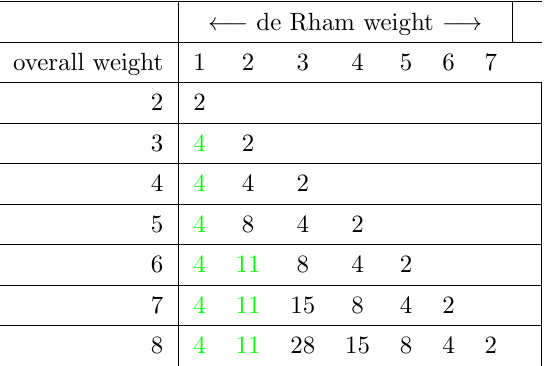
Table 17 . Dimensions of the space K (cid:25) of de Rham entries of the hexagon functions restricted to the line ( (1+ y ) 2 ; 1 ; 1 ). The colored entries mark spaces that are saturated, in the sense that no 4 y 2 2 more functions should appear in K (cid:25) at the given de Rham weight, even when the overall weight is increased